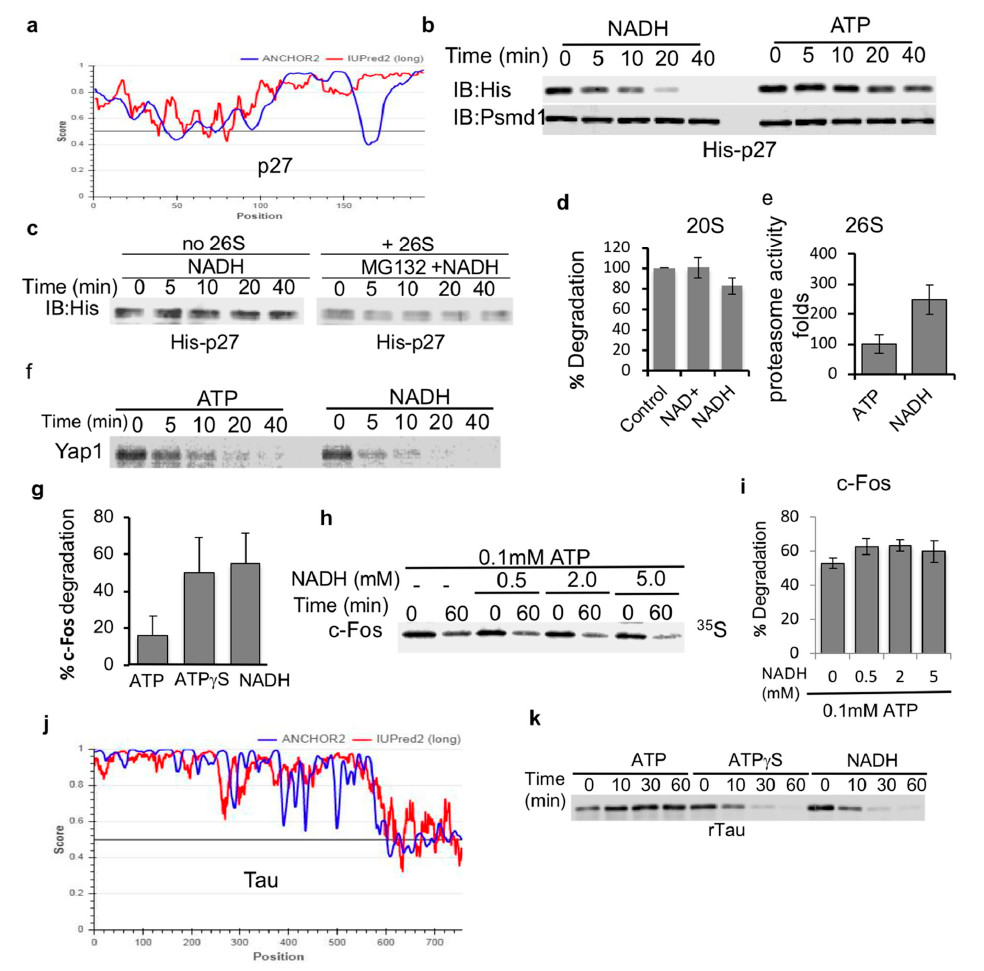
Figure 3. IDPs are susceptible to NADH-26S PC degradation. ( a ) p27 (UniProt P46527) is a disordered protein based on the prediction output using IUPred2A (red curve) and ANCHOR2 (blue curve) prediction programs. ( b ) Recombinant p27 is susceptible to degradation by the NADH-26S proteasome. Purified recombinant p27 protein was subjected to 26S proteasomal degradation. Time kinetics were analyzed for p27 degradation in the presence of either 2 mM ATP or NADH. His-p27 was detected by immunoblotting with anti-His antibody. ( c ) p27 is stable in the presence of NADH alone or in the presence of 26S proteasomes, 2 mM NADH and 25 µ M of the proteasomal inhibitor MG132. ( d ) NADH has minor inhibitory e ff ect on the purified 20S proteasome mediated degradation of synthetic substrate of the Chymotrypsin-like activity as measured based on the hydrolysis of Suc-LLVY-AMC substrate. ( e ) NADH induces the 26S proteasomal activity as measured by the cleavage of the Suc-LLVY-AMC peptide by purified 26S proteasomes in the presence of either 1 mM ATP or NADH. ( f ) In vitro translated purified proteins are degraded by the NADH-26S proteasome. In vitro translated 35 S Methionine labeled flag-Yap1 was purified by flag IP followed by flag elution in the degradation bu ff er (see Section 2). Yap1 degradation kinetics by the 26S proteasome were analyzed in the presence of either 2 mM NADH or ATP. ( g ) Degradation of purified c-Fos was analyzed following 30 min incubation with 26S proteasomes in the presence of 2 mM ATP, ATP γ S or NADH. ( h ) In vitro translated 35 S Methionine-Fos degradation was examined in the presence of 0.1 mM ATP and increasing concentrations of NADH at 37 ◦ C for 60 min. ( i ) The data from at least three independent experiments, as shown in ( h ) were averaged and shown with their standard deviation. ( j ) Tau (UniProt P10636) is a highly disordered protein as demonstrated by the scores of prediction output using IUPred2A (red curve) and ANCHOR2 (blue curve) prediction programs. ( k ) NADH and ATP γ S induce 26S proteasomal degradation of recombinant tau protein (rTau) degradation by the 26S proteasome. Degradation was examined in the presence of either 2 mM ATP, ATP γ S or